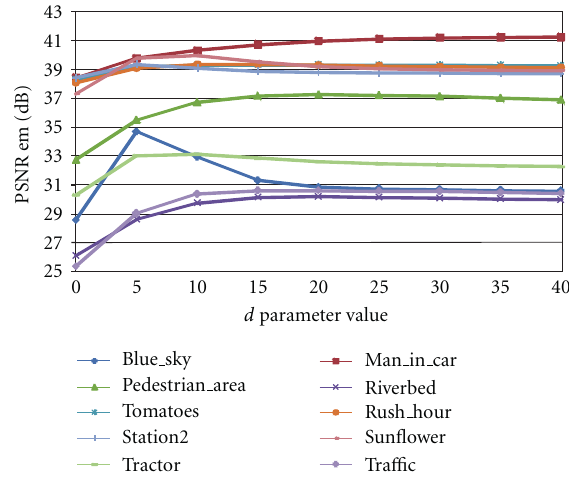
Figure 6: Variation of d parameter for MPDS algorithm.